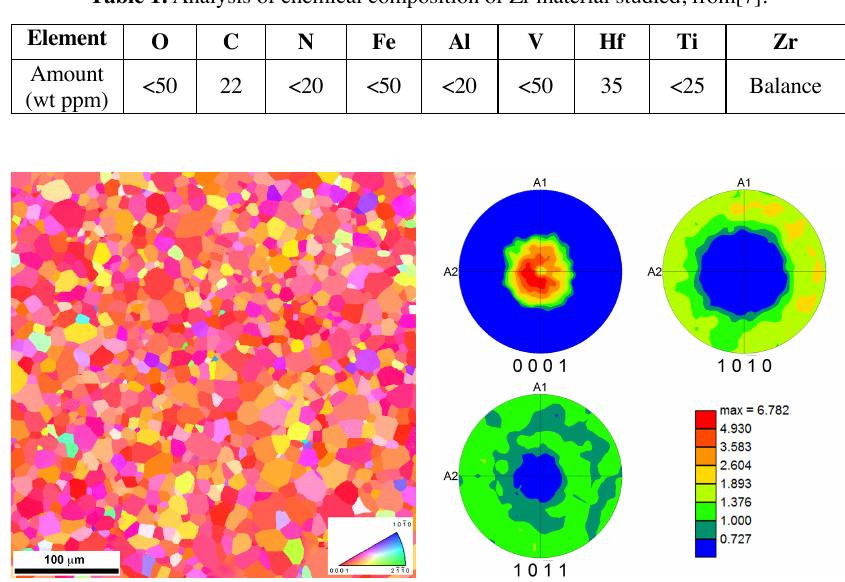
Fig. 1. (a) Inverse pole figure, and (b) texture plot of the annealed Zr sample used as the initial, unshocked state. Readers are referred to the online version for